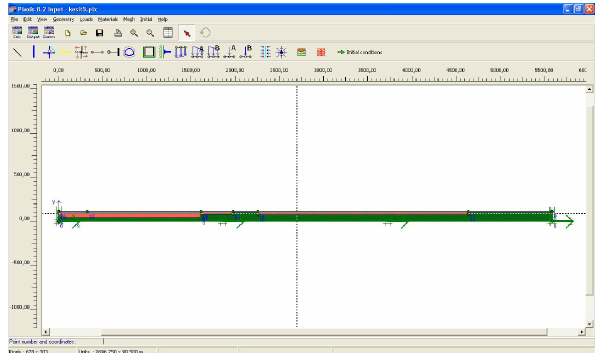
Figure 21: Change of Maximum acceleration by depth for 5 points chosen for the section Figure 21. Change in maximum acceleration by depth for five points chosen for the